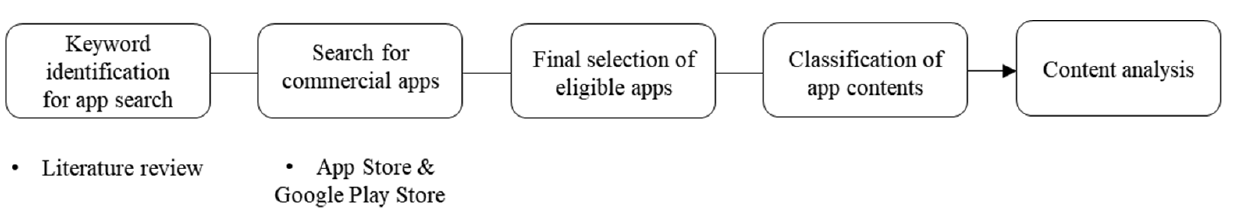
Figure 1. Flowchart of the study.